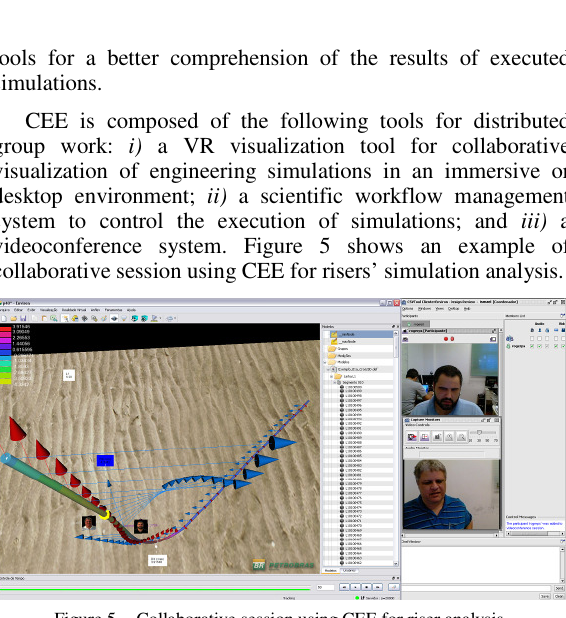
Figure 5. Collaborative session using CEE for riser